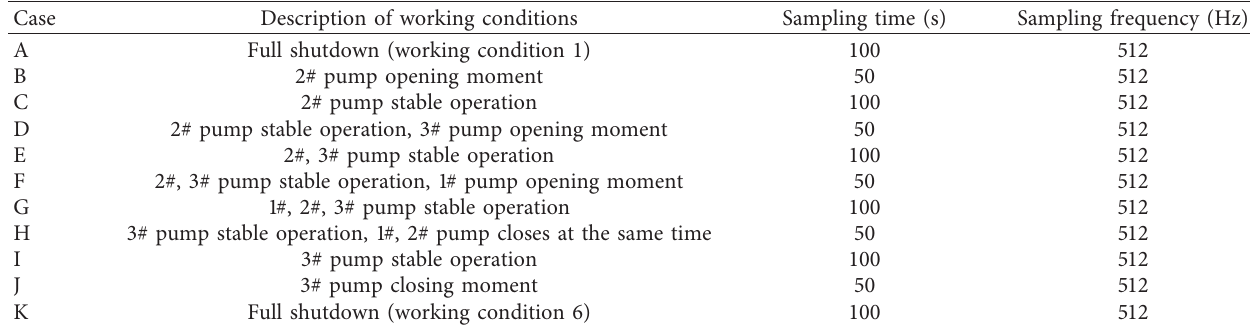
Figure 6: Field test and measuring point layout of the seventh pumping station of Jingtaichuan Project II. (a) Field test of pipeline. (b) Measuring point layout of pipeline. Table 1: Test conditions of pipeline